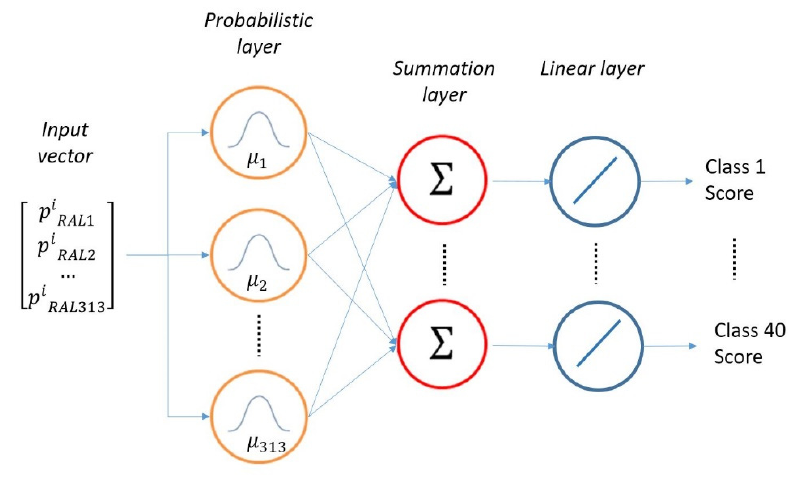
Figure 6. PNN architecture.